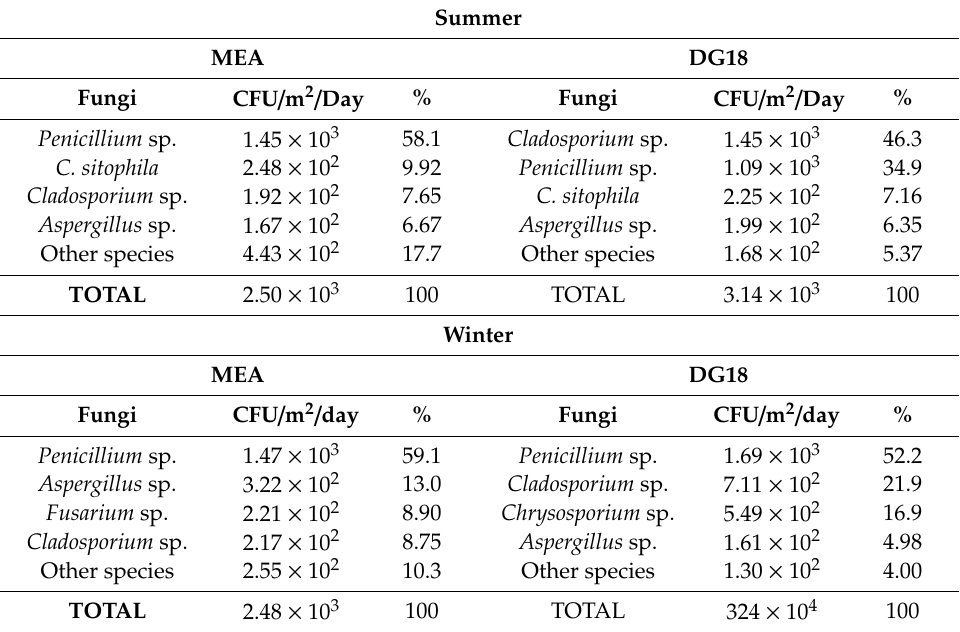
Table 6. Fungal contamination found in each